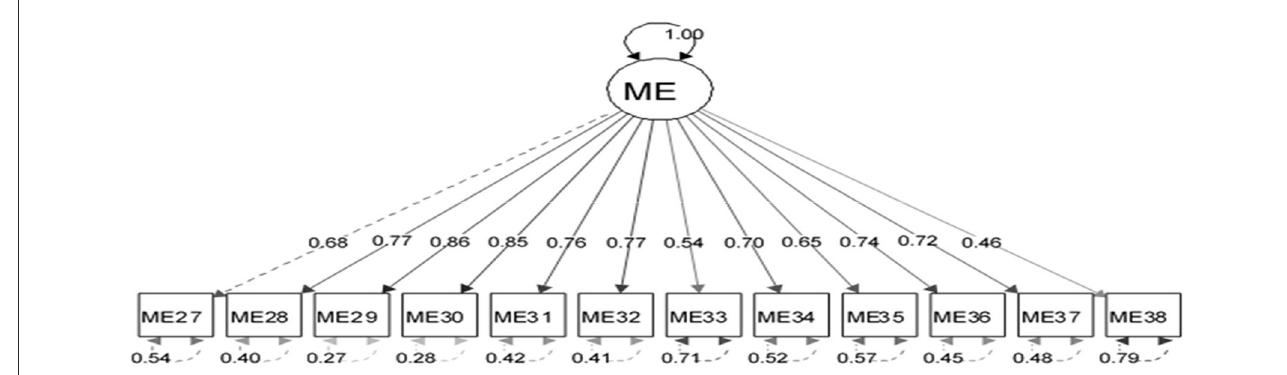
FIGURE5 Confirmatory factor analysis model of the therapeutic dimension of the family support for older people questionnaire. All items in the questionnaire showed a factor load > 0.3, indicating appropriate metrics for the tool factor.